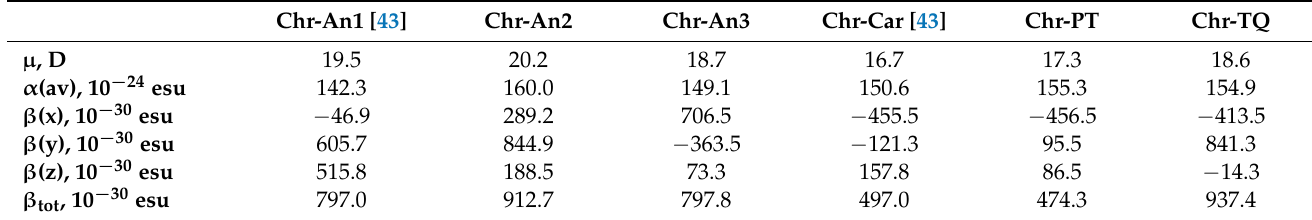
Table 3. Electric characteristics of the studied chromophores ( tct conformers).